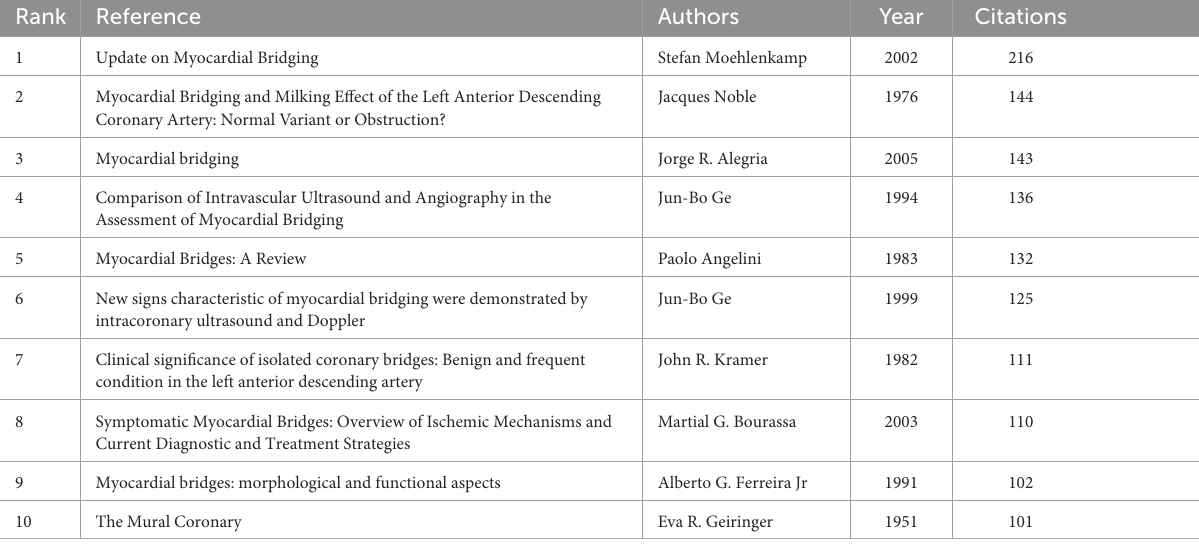
TABLE 5 Top 10 references with highest citations.